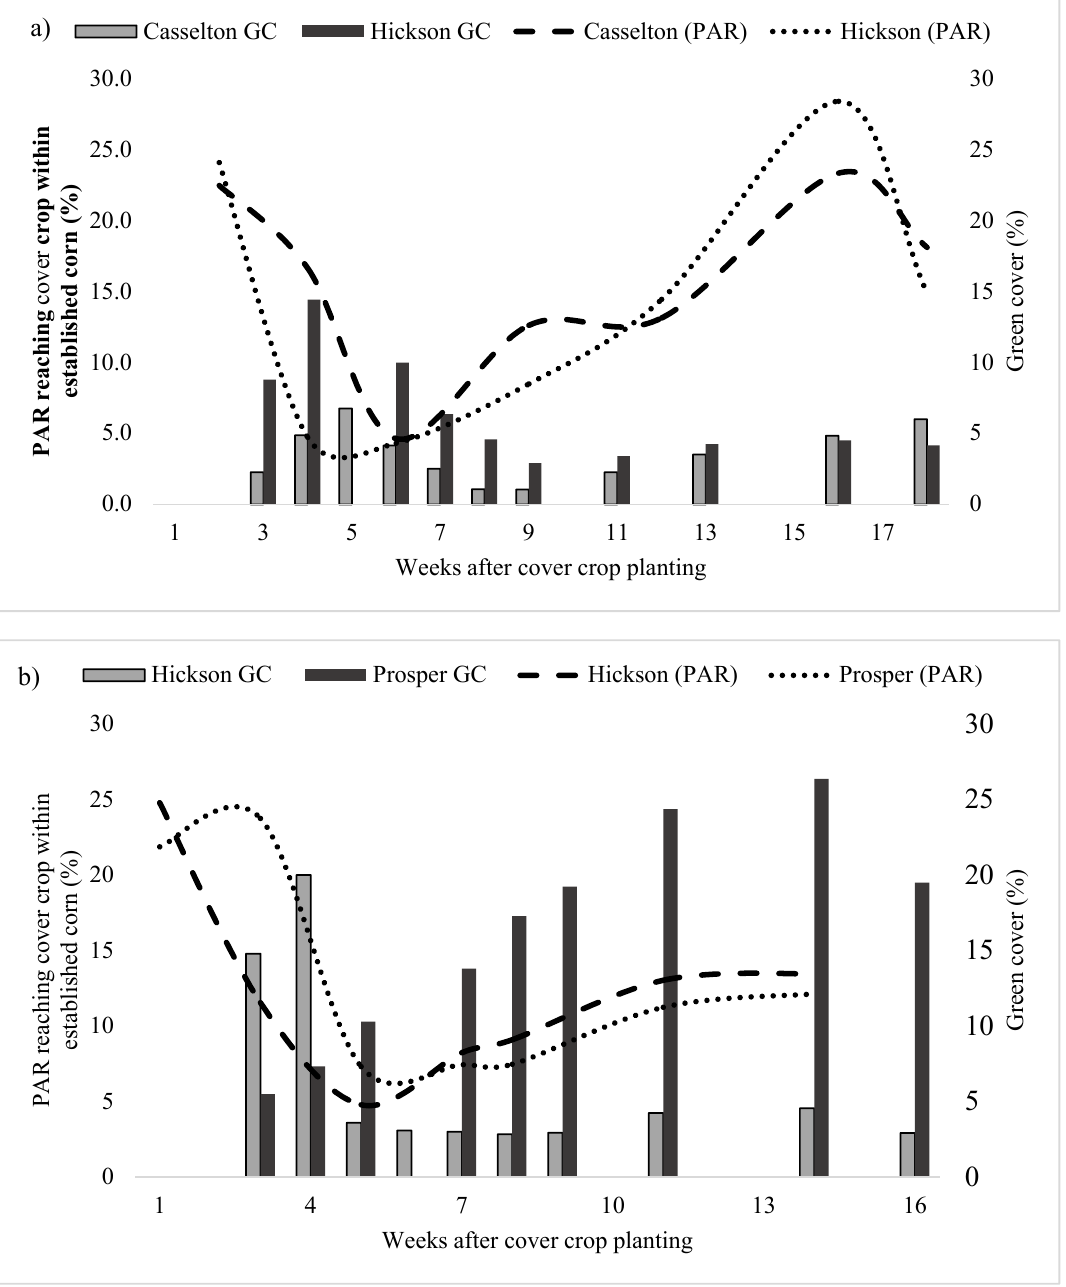
Figure 2. Percent green cover (GC) for cover crops planted at the V7 maize growth stage in relation to photosynthetically active radiation (PAR) reaching the cover crop canopy within the established maize at ( a ) Casselton and Hickson, ND, in 2018 and ( b ) Hickson and Prosper, ND, in 2019.